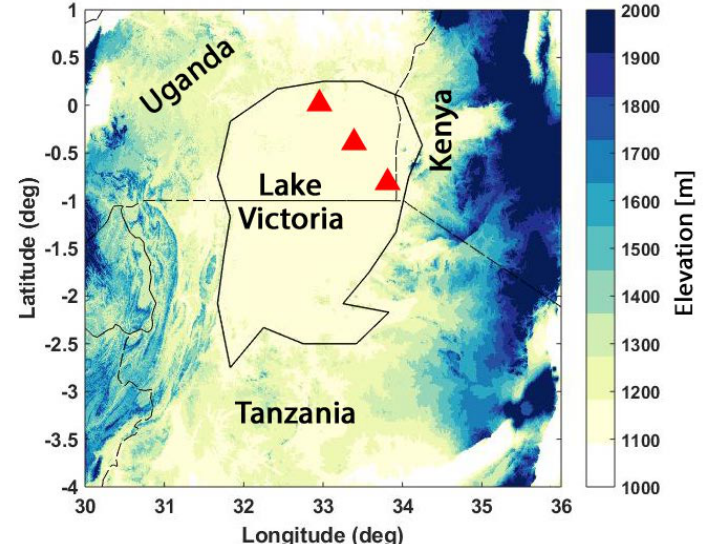
Figure 1. The Lake Victoria boundary (black) with the borders of Kenya, Uganda and Tanzania presented on the region’s digital elevation map. The location of virtual stations for the altimetry water level data are presented in red